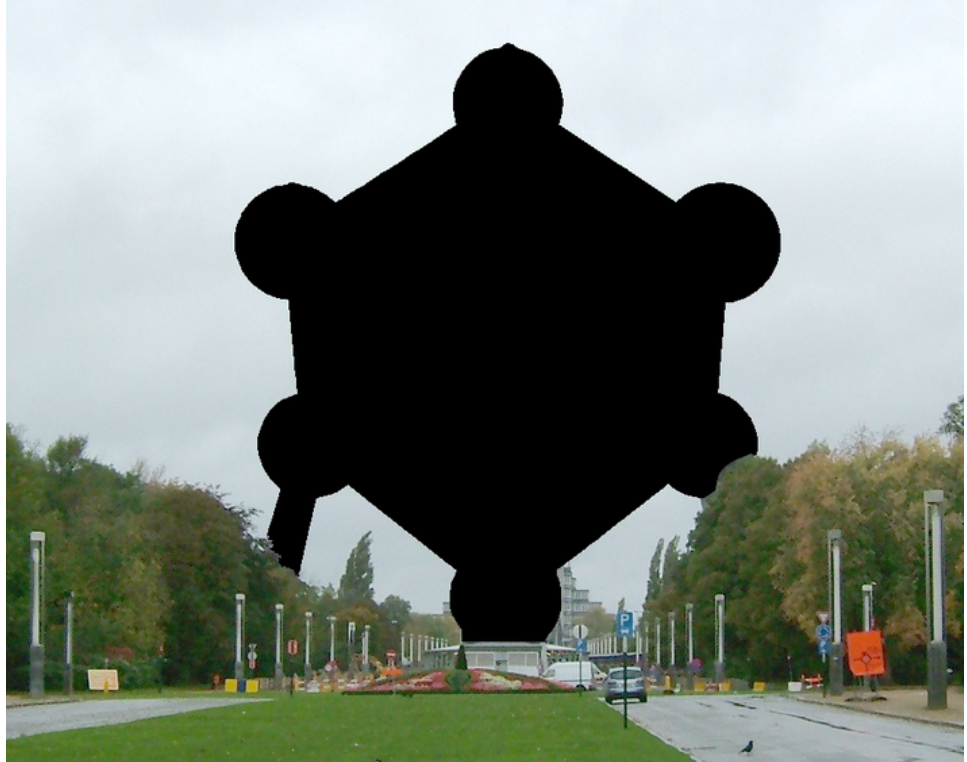
Figure 1: A "blacked-out" reproduction of the Atomium of Brussels